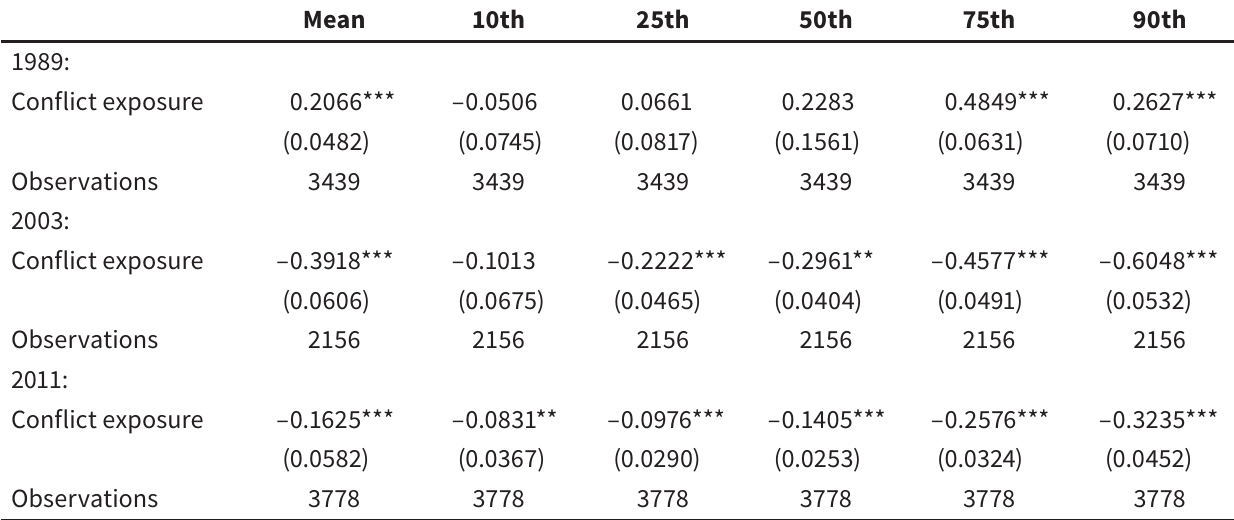
Table A2.13 Quantile Treatment Effects using Log Household Expenditure Based on Conflict Exposure with more than Eight Years of Rebel Occupation (with 64 chiefdoms) Mean 10th 25th 50th 75th 90th